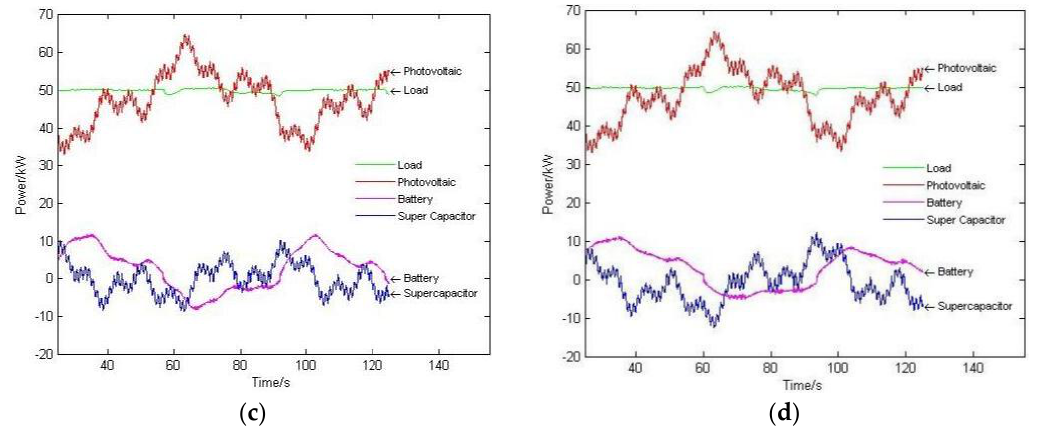
Figure 10. Output waveforms for different time constants for short time scale. ( a ) T = 0.1 s; ( b ) T = 1 s; ( c ) T = 5 s; ( d ) T = 10 s.